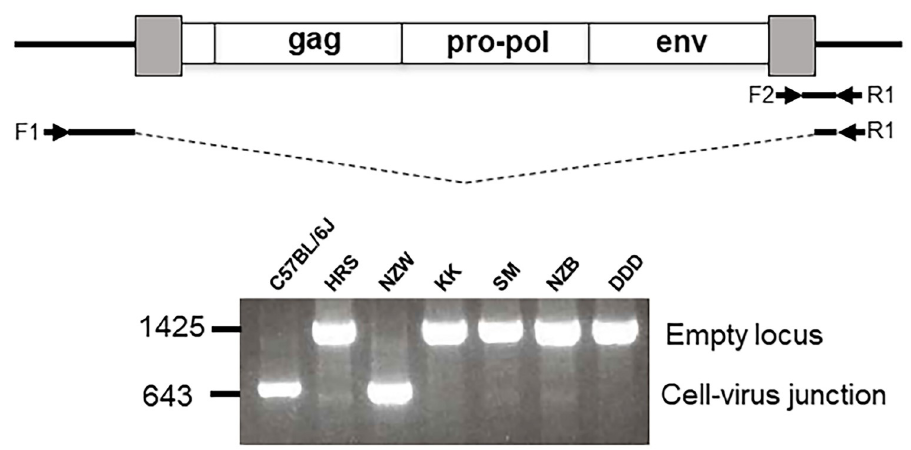
Fig 3. Detection of a representative ERV, Pmv7 , in 7 inbred strains. At the top is a diagram of the provirus and cellular flanks with arrows showing positions of 3 primers and the expected products for mice with and without the Pmv7 insertion. At the bottom are PCR test results for 7 strains using the three